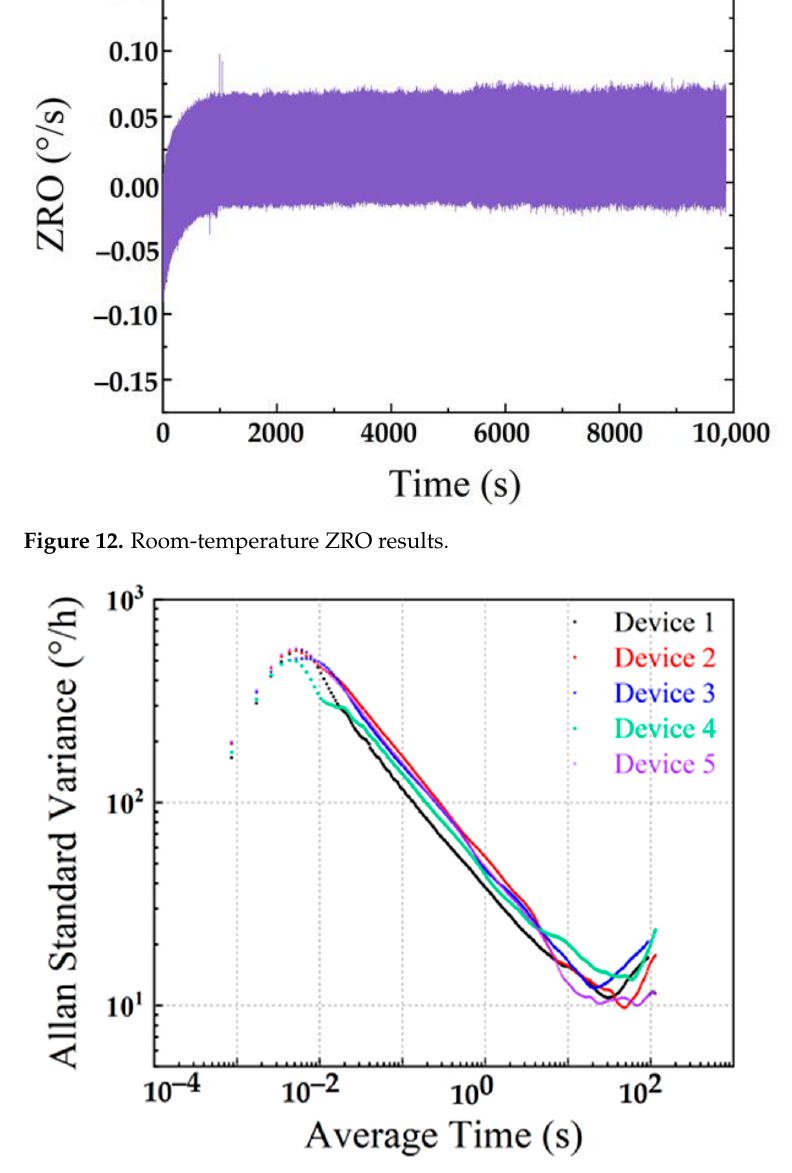
Figure 13. The Allan standard variance analysis results for typical BFVG. Table 5. The Allan standard variance results of five typical